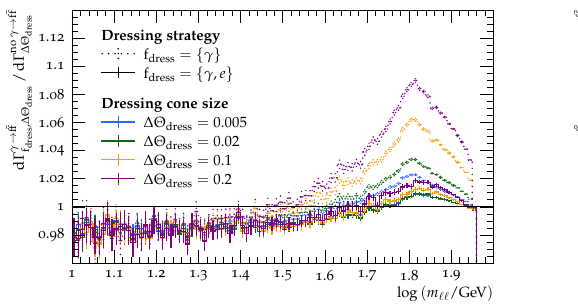
f¯f / d log m ‘‘ , ∆Θ dress